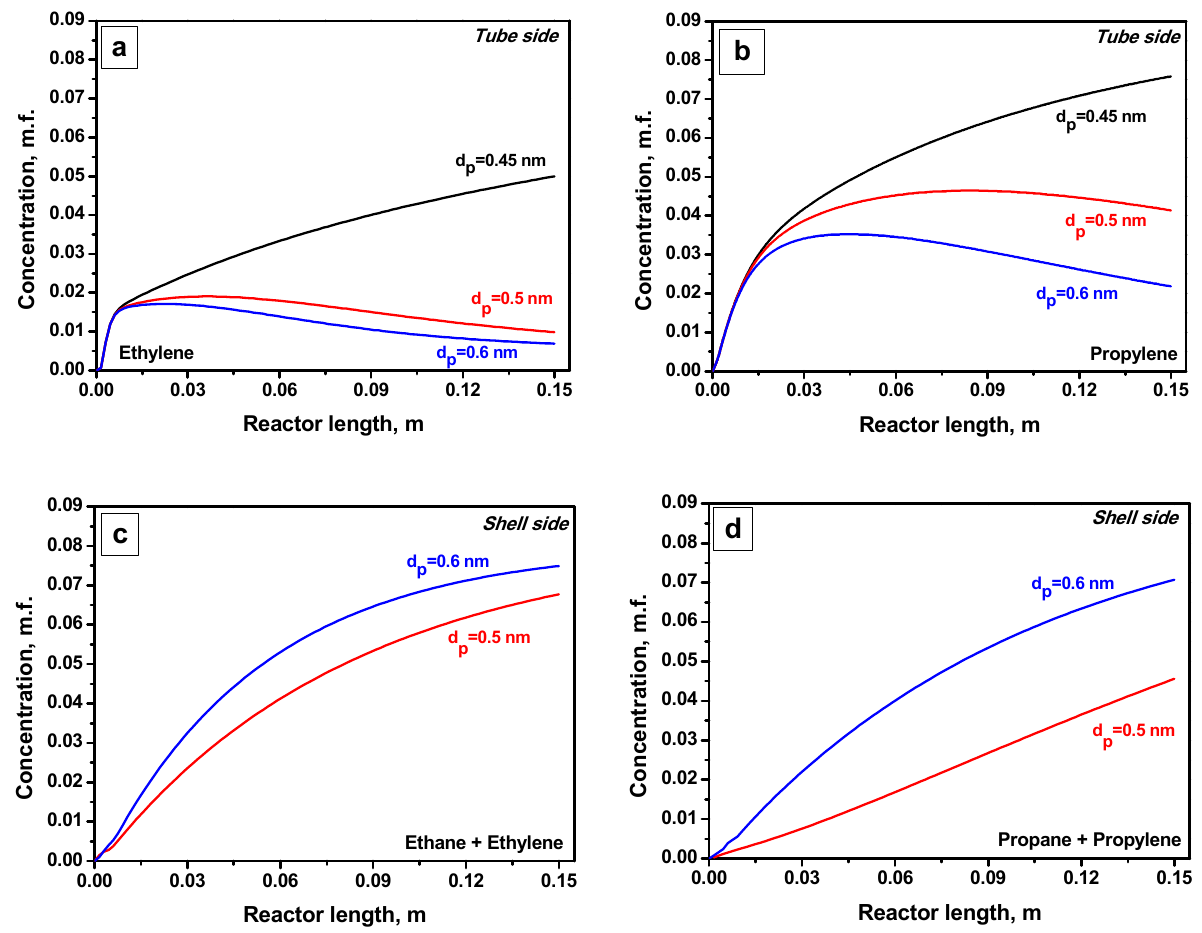
Figure 9. Concentration profiles along the reactor length: ethylene in the tube side ( a ); propylene in the tube side ( b ); sum of ethane and ethylene in the shell side ( c ); sum of propane and propylene in the shell side ( d ).